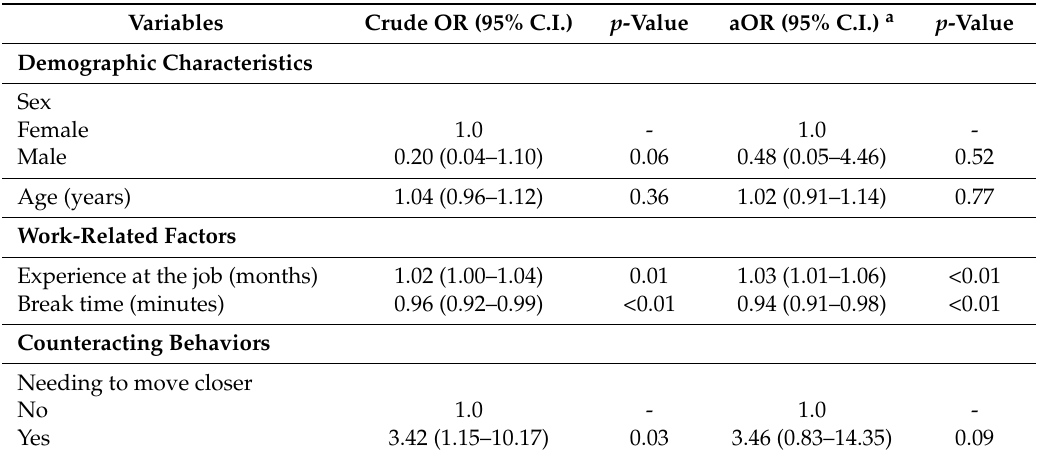
Table 4. Univariate and multivariate logistic regression analysis of factors influencing eye